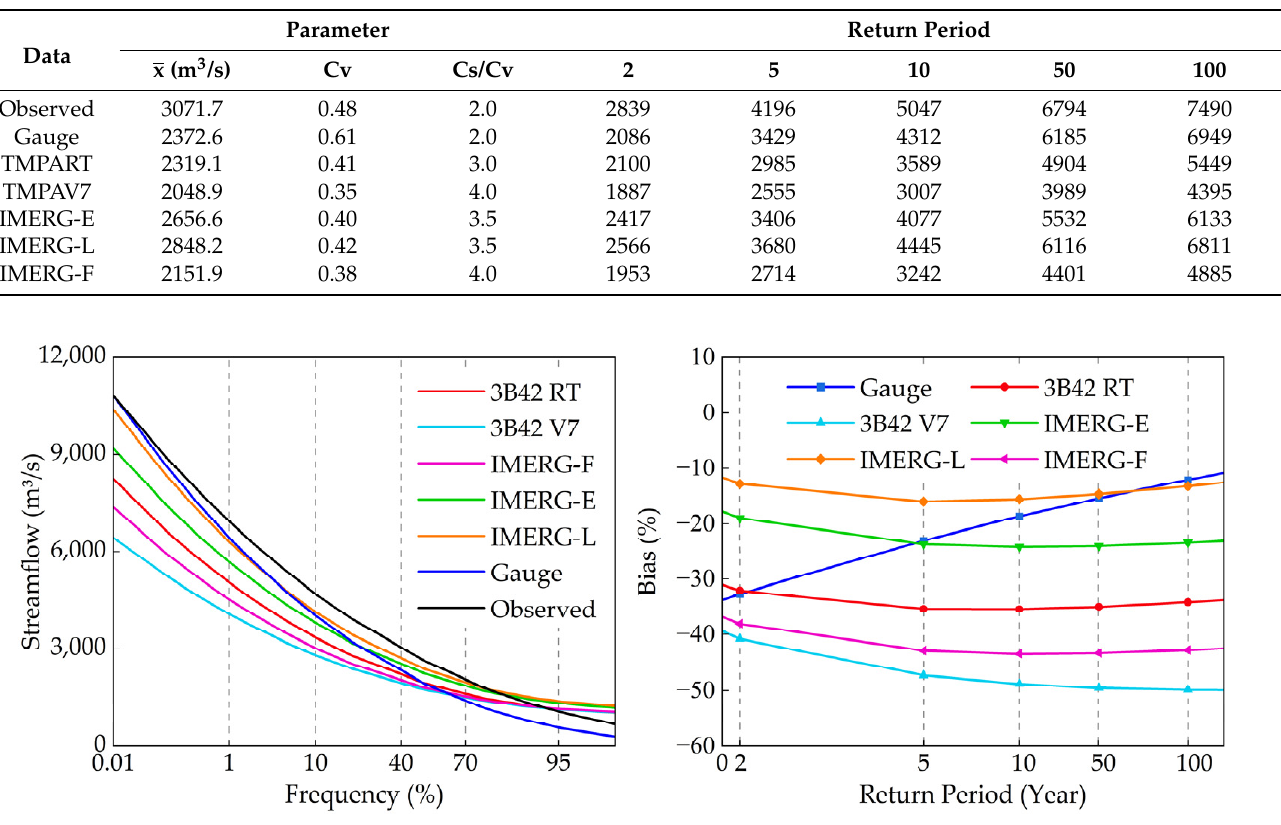
Figure 8. Comparison of the flood-frequency curves based on the observed and simulated peak flows and the bias of design floods.